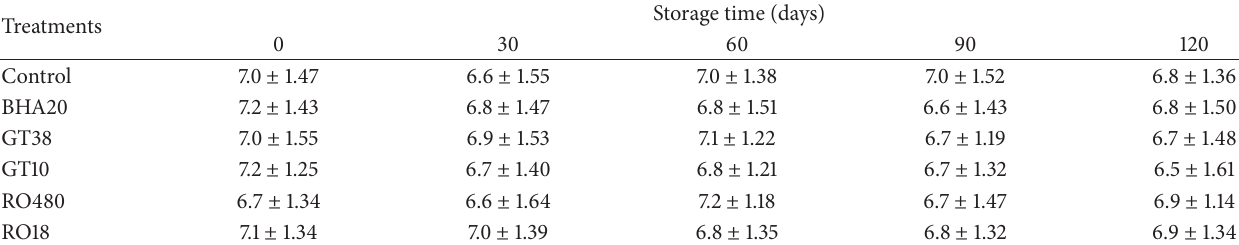
Table 2: Results of sensory acceptance of chicken burgers during storage